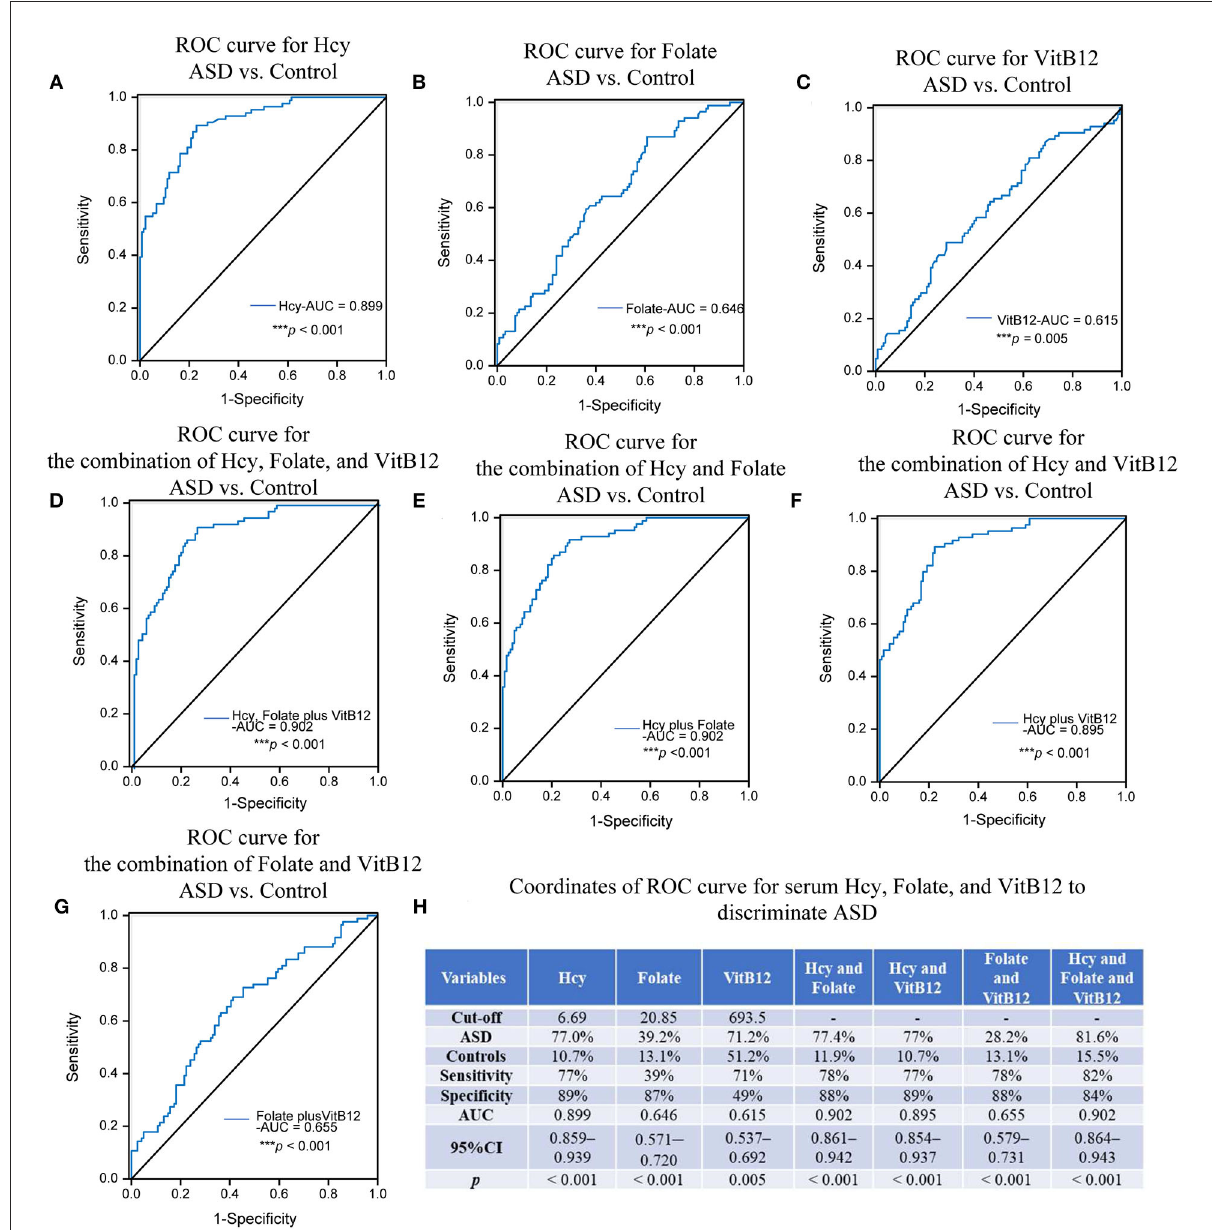
FIGURE4 ROC analysis of Hcy, folate, and VitB12. The AUCs of the ROC curves for (A) Hcy, (B) folate, and (C) VitB12 were 0.899 (*** p < 0.001), 0.646 ( p = 0.230), and 0.615 (*** p < 0.001), respectively. The AUCs of the ROC curves for (D) Hcy + folate + VitB12, (E) Hcy + folate, (F) Hcy + VitB12, and (G) folate + VitB12 were 0.902 (*** p < 0.001), 0.902 (*** p < 0.001), 0.895 (*** p < 0.001) and 0.655 (*** p < 0.001), respectively. (H) Coordinates of ROC curve for Hcy, folate, and VitB12 to discriminate ASD from heathy controls. Hcy, homocysteine; VitB12,